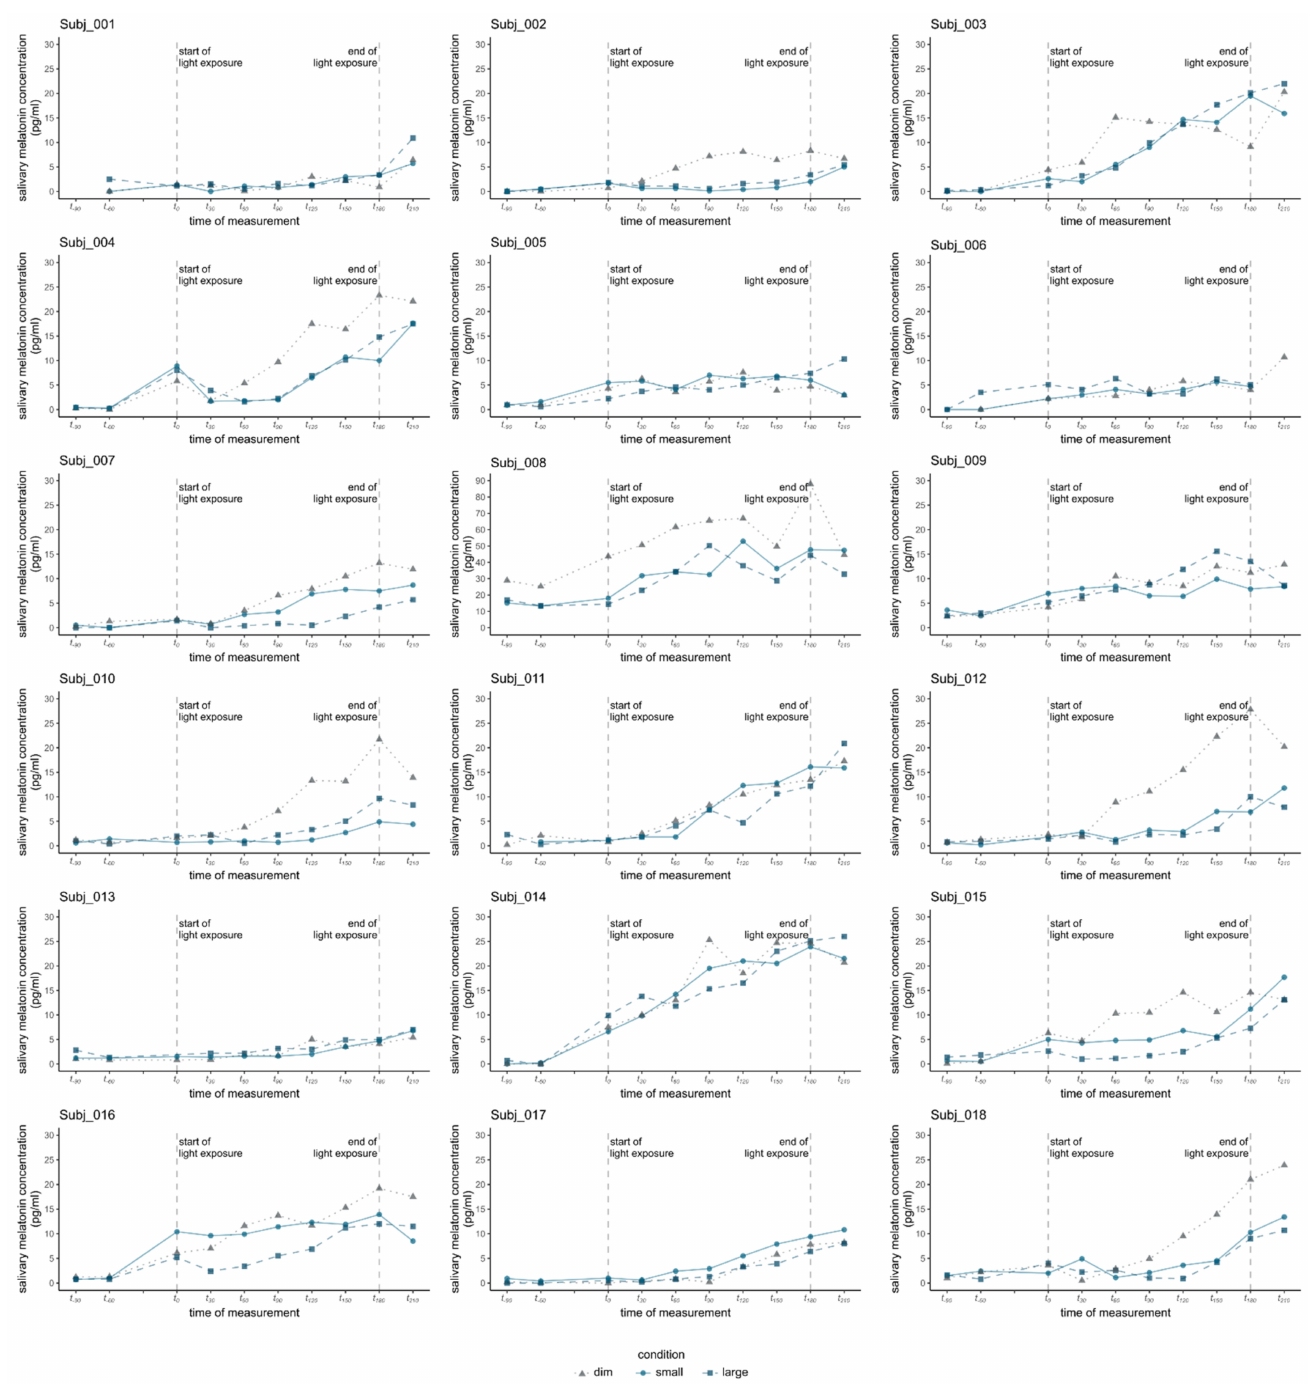
Figure A1. Individual courses of melatonin concentrations. Note: For subject Subj_008 a different scaling of y-axis is used. Due to the significant higher concentrations, subject Subj_008 was excluded from all other evaluations and